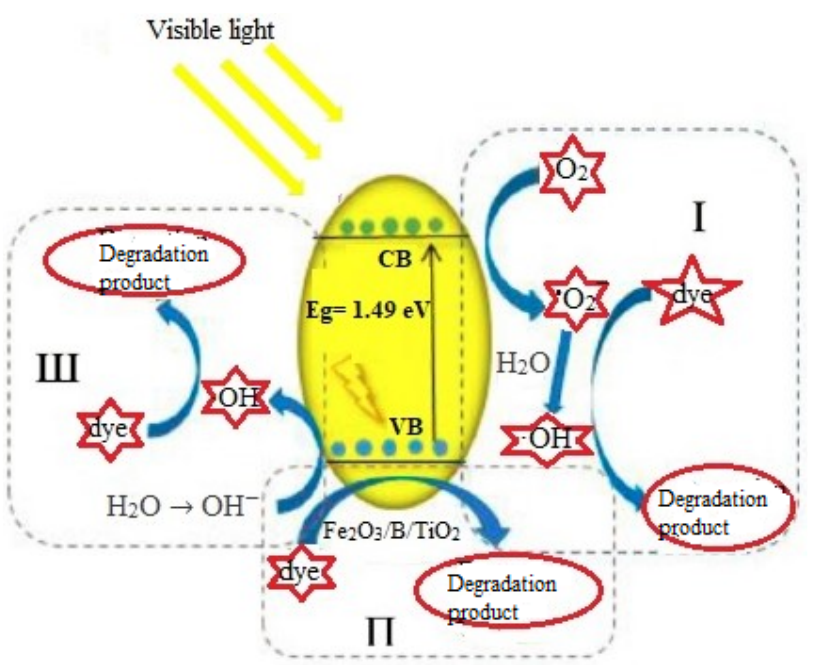
Figure 8. Mechanism of RR198 degradation via photocatalysis with Fe 2 O 3 /B/TiO 2.